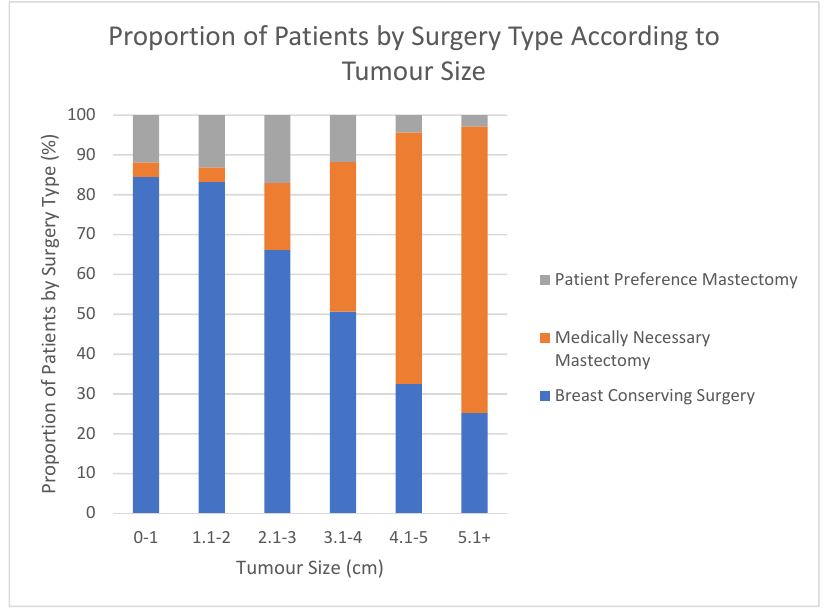
Figure 3. Proportion of patients with invasive cancer receiving either BCS, TMMN, or TMPP by tumour size. Within each invasive tumour size, the proportion of patients receiving BCS, TMMN, and TMPP was indicated. Trend analysis revealed that 80% of our patients would be eli- gible for BCS with a preop tumour size cut-off of 2.5 cm inclusively. For patients with preop tumour size up to 2 cm in size 135 patients had mastectomies: 31 patients TMMN (2.8%) and 104 patients TMPP (9.7%).